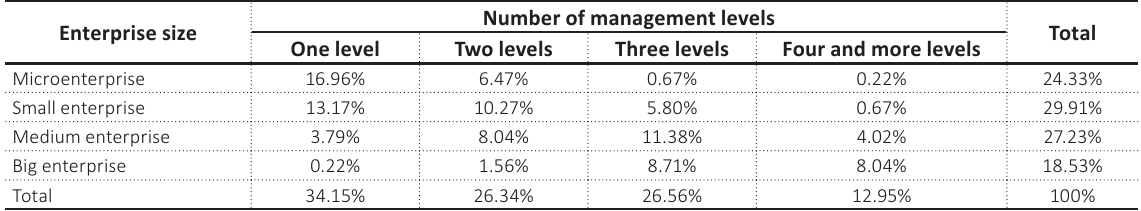
Table 2. Dependence between the number of management levels and the size of an enterprise Enterprise size